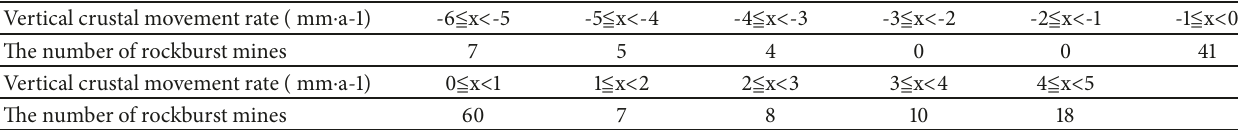
Table 4: Distribution of rockburst coal mines in different crust movement rates.